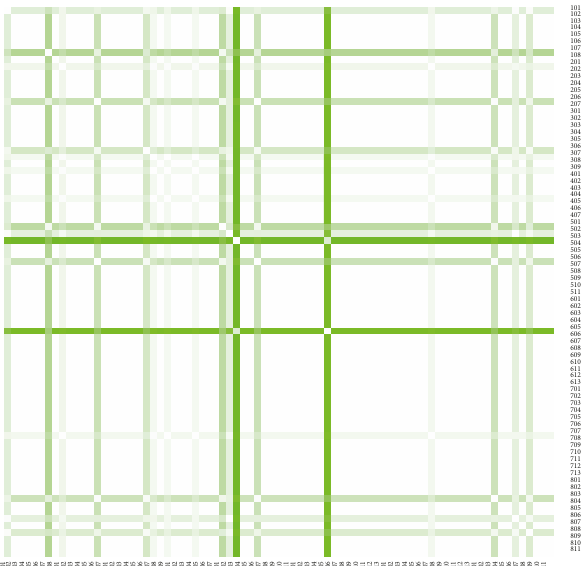
Figure 10: The distance matrix of the similarity of the districts for the male sex in 1996.